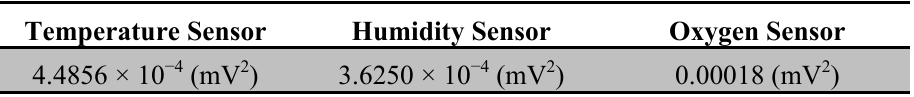
Table 2. MSE between measured data and the a posteri estimated